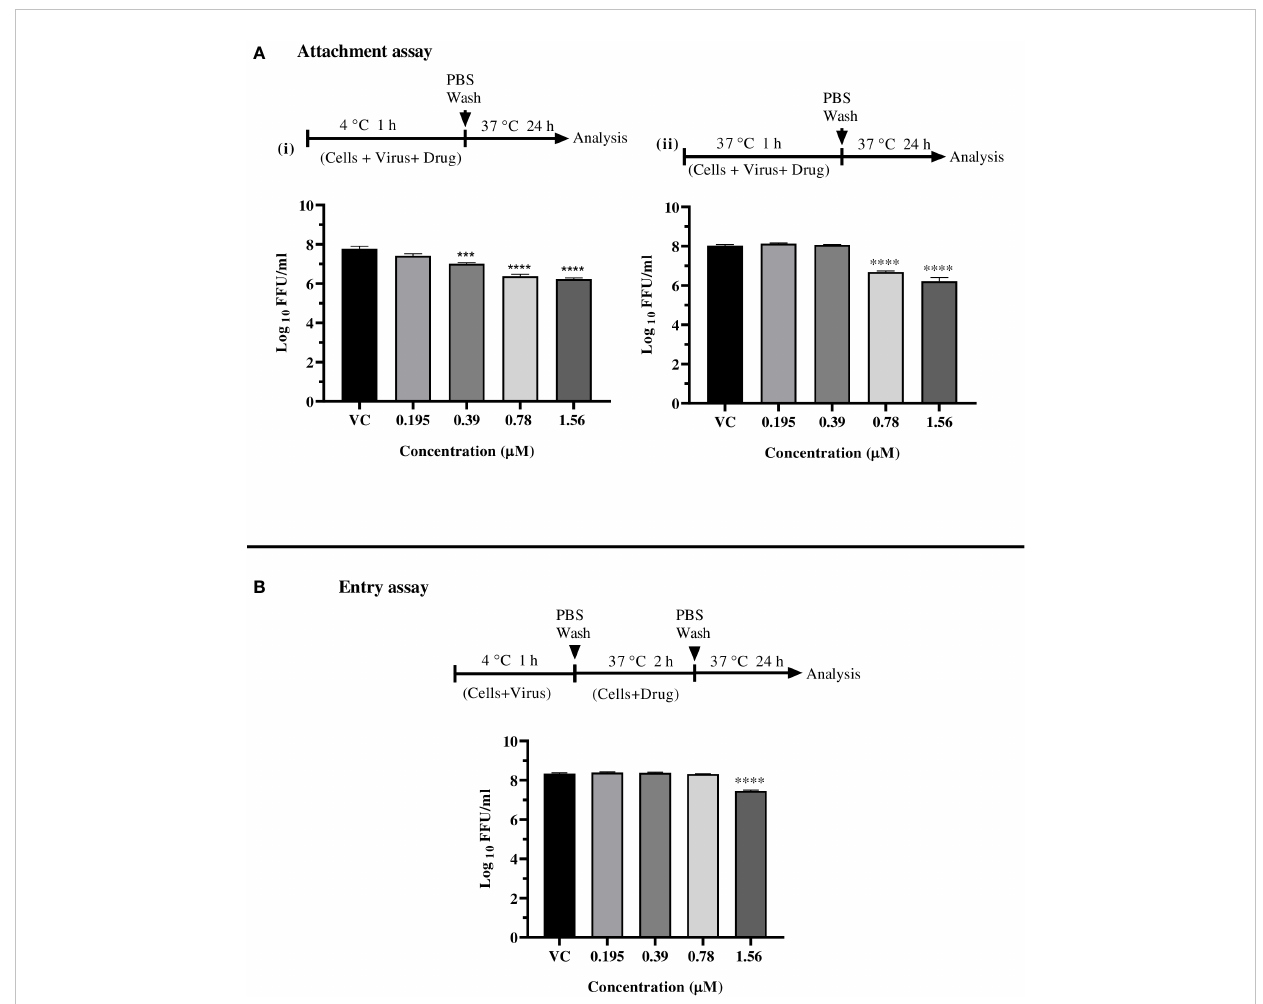
FIGURE 4 Effect of enalaprilat against virus attachment and entry. (A) Attachment assay at 4°C (i) and 37°C (ii)- The experimental procedure, virus concentration, and the time of addition and treatment with the drug are presented for CHIKV in schematics and the graphs. The log 10 values were determined by counting the number of foci and were compared with the virus control group. Each data point is the mean log 10 focus forming unit/ ml ± standard error. ****p< 0.0001. (B) Entry assay at 4°C - The log 10 values were determined by counting the number of foci and compared to that of the virus control group. Each data represents the mean log 10 focus forming unit/ml ± standard error. ***p<0.005, ****